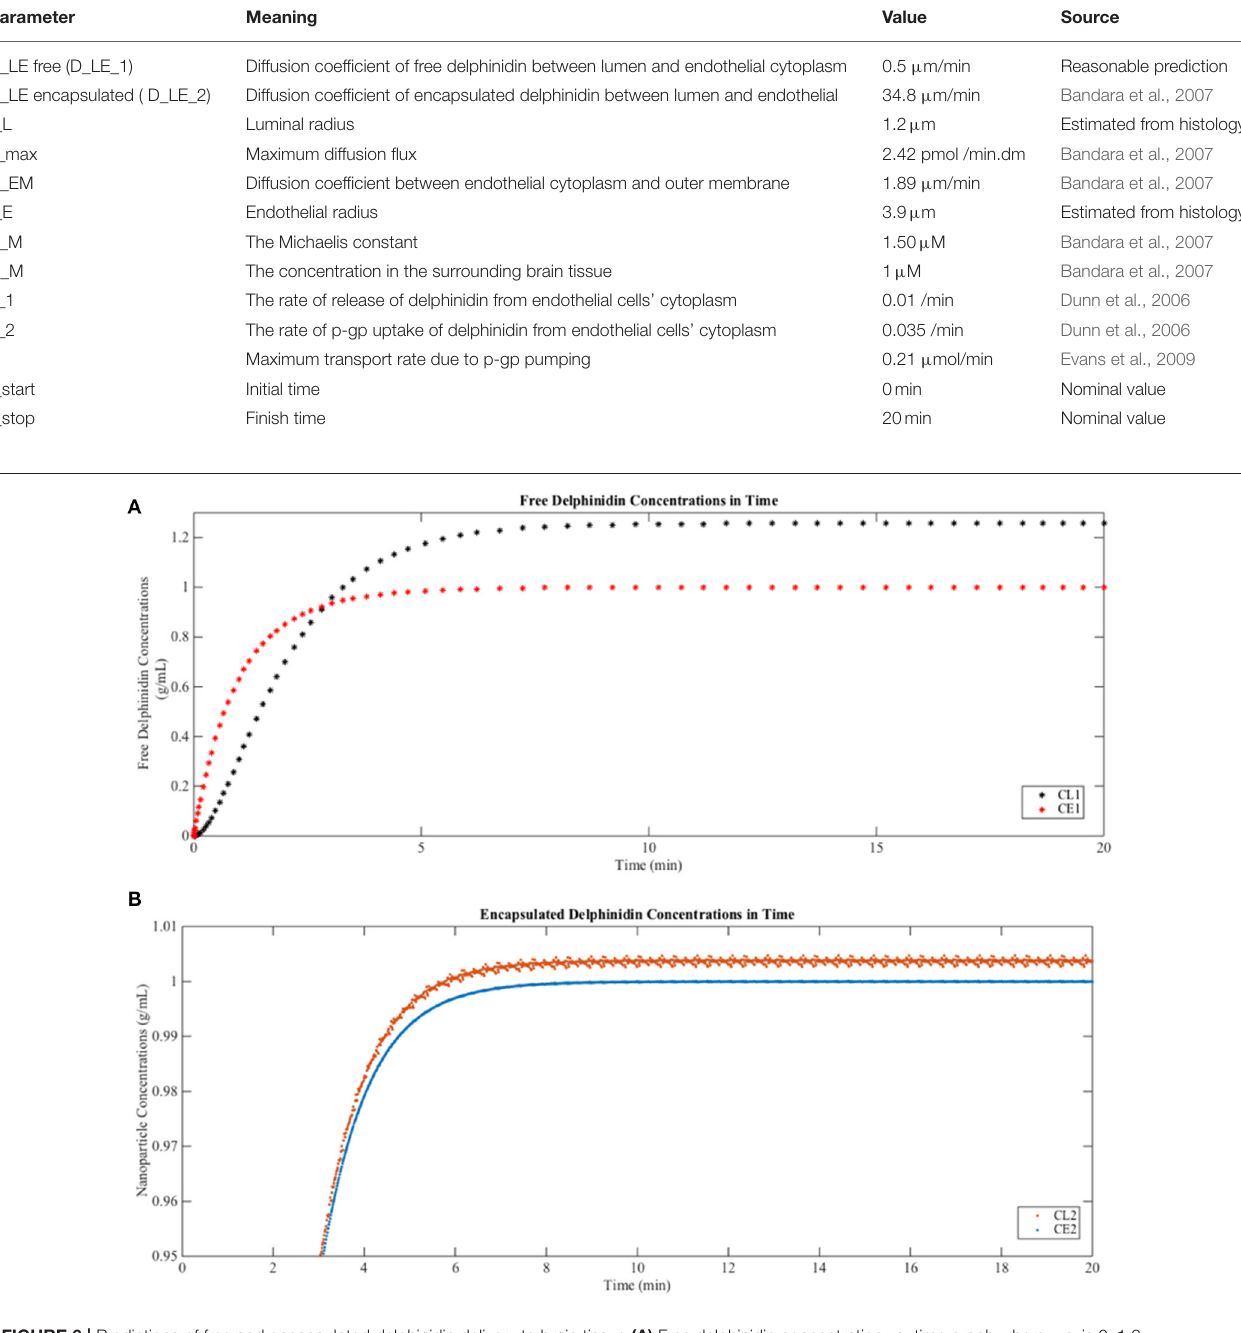
FIGURE 6 | Predictions of free and encapsulated delphinidin delivery to brain tissue (A) Free delphinidin concentration vs. time graph where y-axis 0–1.3. (B) Encapsulated delphinidin concentration vs. time graph where y-axis 0.95–1.01. CL, concentration in the lumen; CE, concentration in the endothelial cells of the